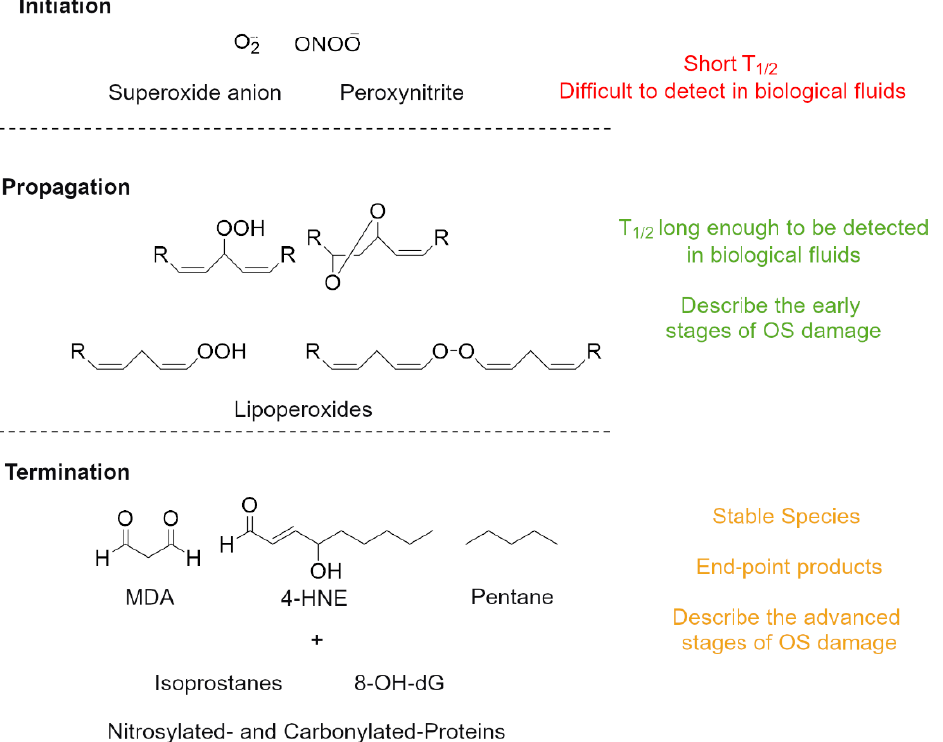
Figure 6. Schematic representation of the sequential reactions occurring in the d-ROMs test. 6. Relation of d-ROMs to Cardiovascular Risk Factors The relevance of d-ROMS to known CVD risk factors is increasingly being recog- nised. Although more work is needed on this topic, particularly with respect to clinical outcomes in prospective studies, several meaningful associations have been reported so far. A Japanese study of 1992 healthy middle-aged subjects found significant associations of serum d-ROMS with age, systolic blood pressure, fasting glucose, and low-density